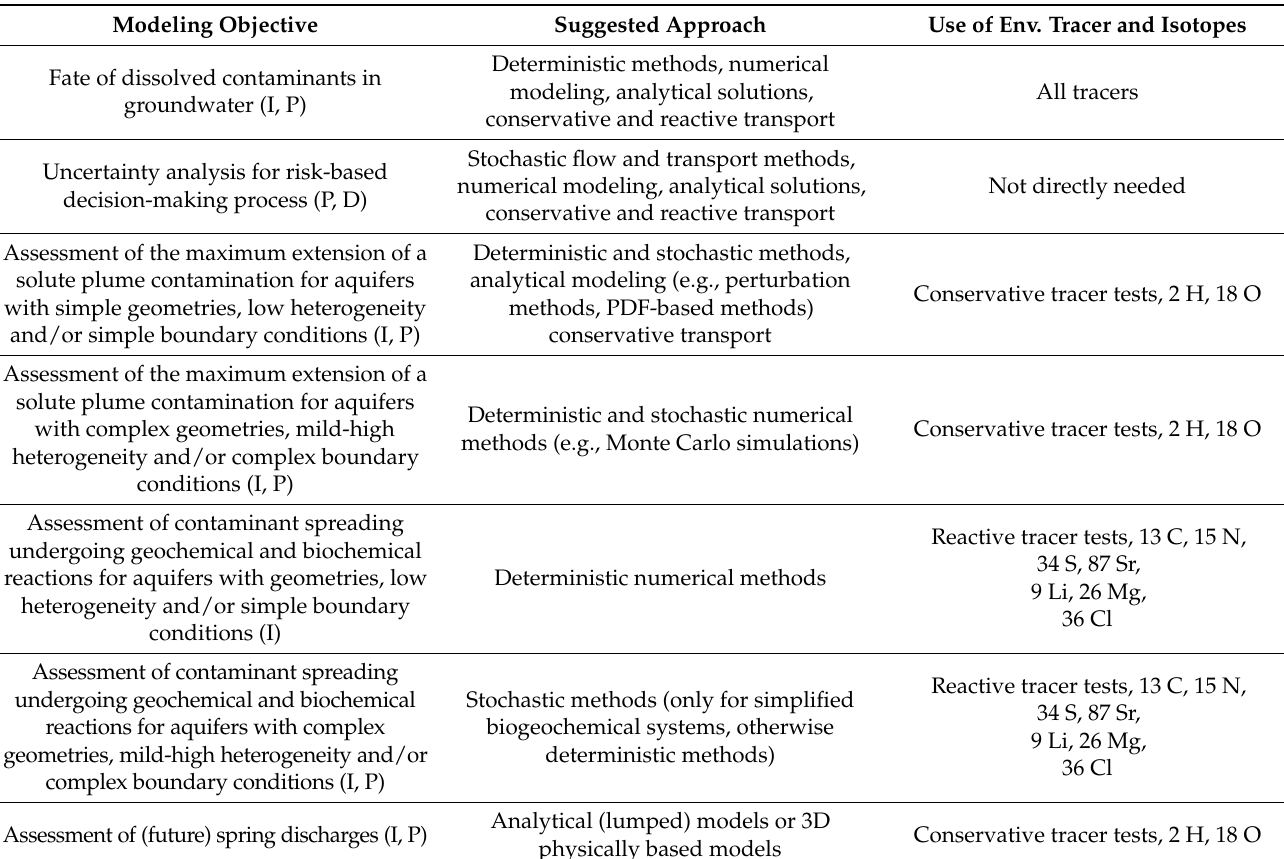
Table 4. Numerical modeling of the saturated zone combined with environmental tracers. General purposes: (I) Interpretation: models are applied to help the interpretation of processes as described by field or laboratory data; (D) Design: models are applied to evaluate and compare the performance of design alternatives; (P) Prediction: models are applied to provide a final, quantifiable prediction of actual field behavior.